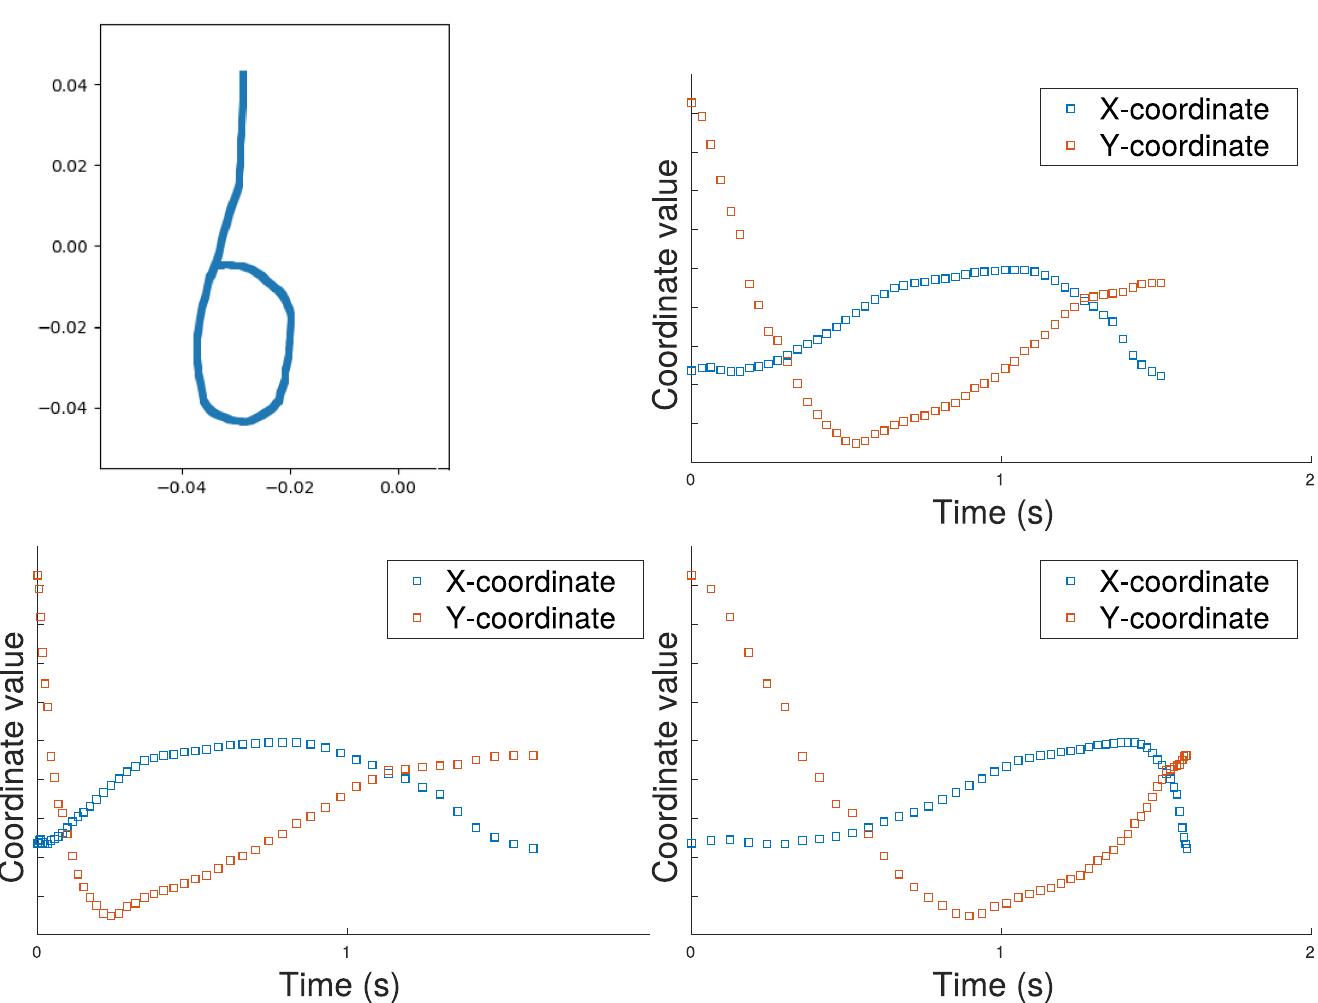
Fig 5. Invariance of the path signature under time reparameterisation. Top left: a path generated by drawing the letter ‘b’ from the top down. Top right: original time series generated by regular sampling of the X- and Y- coordinates of the path. Bottom left: speed increased at start of drawing. Bottom right: speed increased at the end of drawing. In contrast to features derived from the time series, the signature uniquely characterizes the original path. The path signature of degree 2 is {1, − 0.0013, − 0.0464, 0.0000, 0.0007, − 0.0006, 0.0011}.